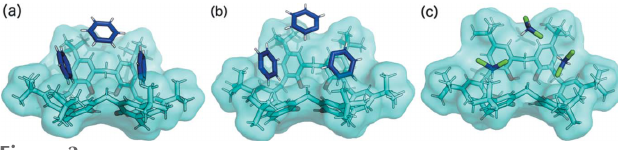
Figure 3 The asymmetric units of TBC6 solvated with ( a ) benzene ( 1 ), ( b ) pyridine (1:3, 2 ) and ( c ) DCM (1:3, 3 ). Disorder has been removed for clarity. From right to left, the guest molecules in the binding pockets represent dimer motifs I, I 00 and I 0 .